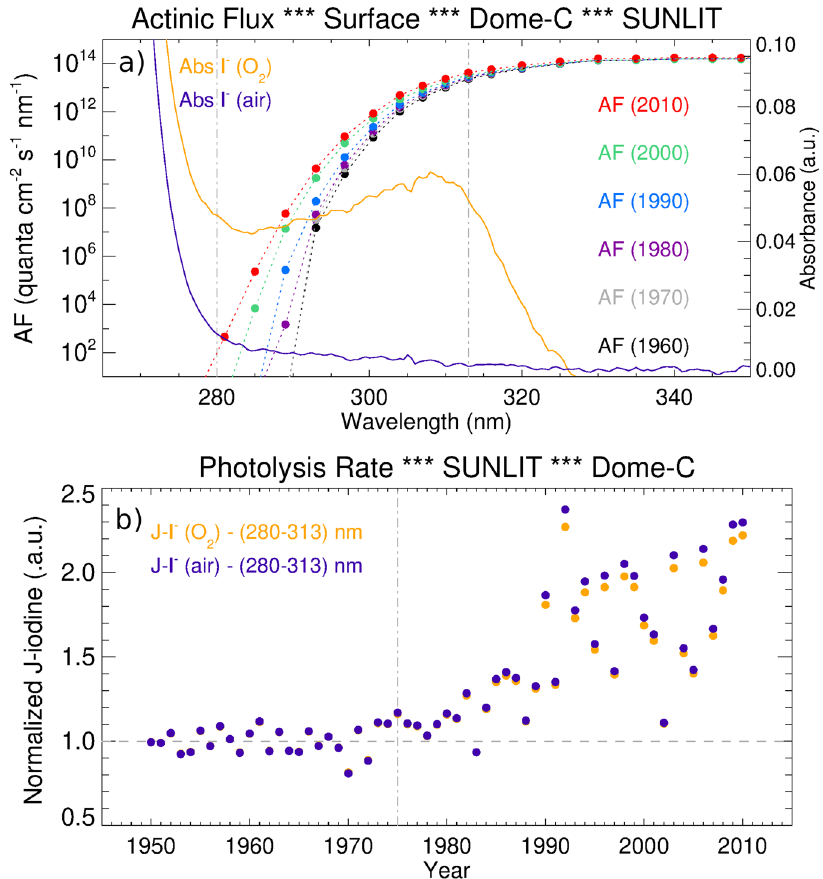
Fig. 2 Iodine photochemical enhancement during the ozone hole period. Modelled actinic fl ux (AF) and iodine photoactivation ef fi ciency (J-iodine) at the snow surface in Dome C. a Wavelength-dependent AF reaching the model surface every decade since the 1960s (colour dots, left Y -axis). The right Y -axis shows the absorbance spectra of a frozen iodide solution in equilibrium with oxygen (I - (O 2 )) and air (I - (air)) environments. b The normalized J-iodine of snow-trapped iodine between 1950 and 2010 relative to the mean J-iodine for the pre-1975 period (dashed-grey horizontal line in ( b )). J-iodine wavelength integration was performed within the 280 – 313 nm band (see dashed-grey vertical lines in ( a )) and continuously increased after 1975 due to the ozone hole- driven enhancement in UV radiation during the sunlit period of each year (i.e., from 1 September to 28